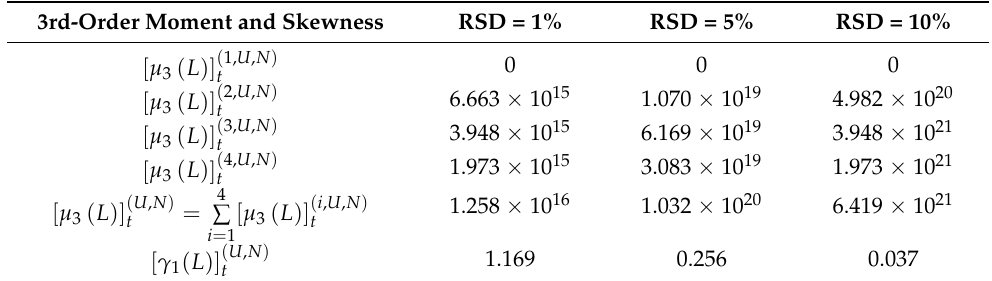
Table 3. Comparison of the 3rd-Order Response Moment and Skewness for Various Relative Standard Deviations (RSD) of the Normally-Distributed and Uncorrelated Microscopic Total Cross